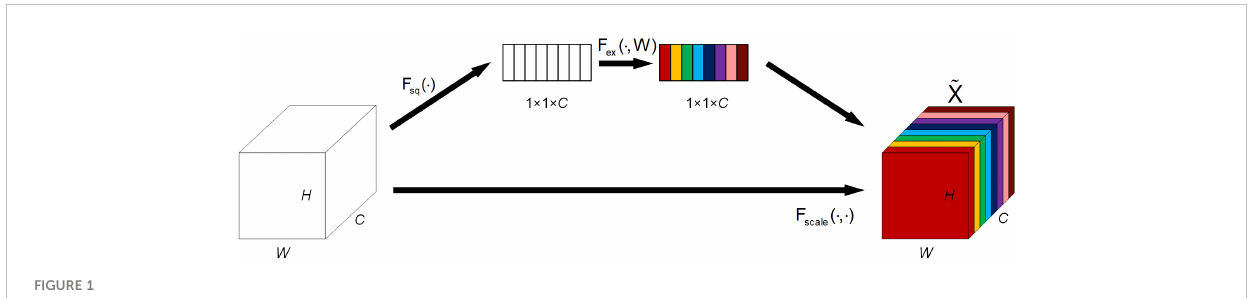
FIGURE 1 The structure of the SE